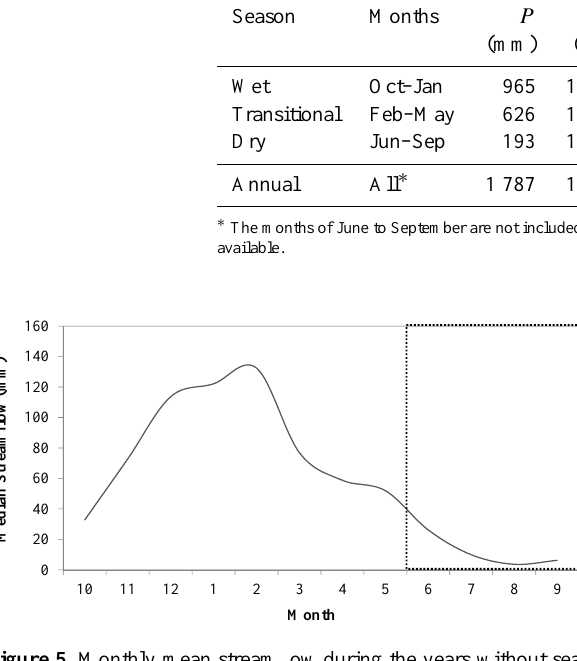
Figure 5. Monthly mean streamflow during the years without sea- sonal impoundments; the boxed off period (June–September) indi- cates the period removed from the streamflow and baseflow analy-